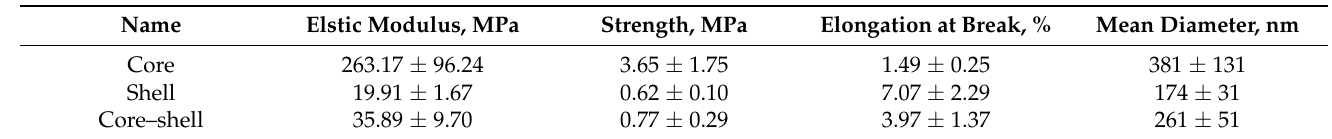
Table 3. The tensile properties of core–shell (PVA-PEG-SiO 2 @PVA-GO), core (PVA-PEG-SiO 2 ), and shell (PVA-GO)